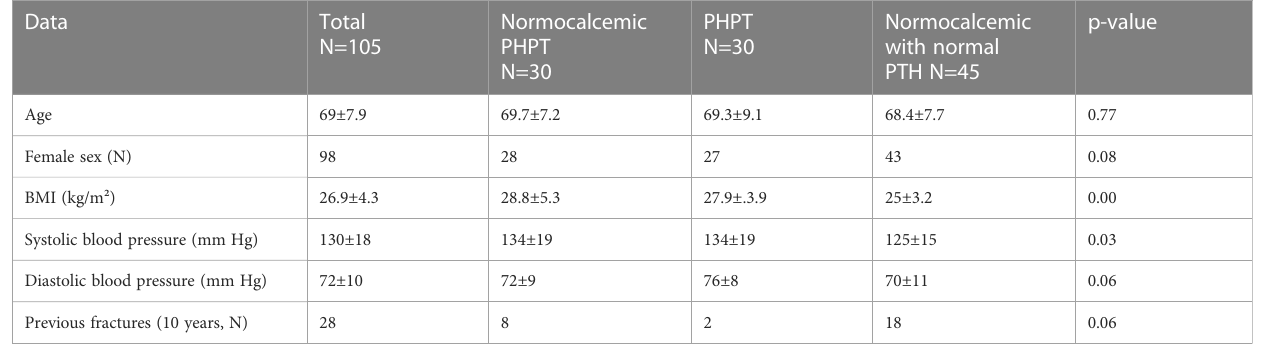
TABLE 1 Clinical and anthropomorphic